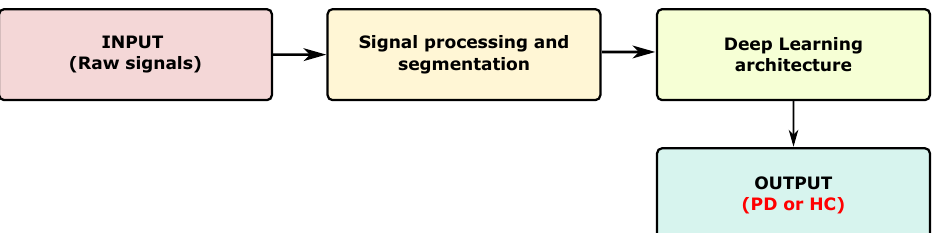
Figure 1. Scheme of the general methodology addressed in the